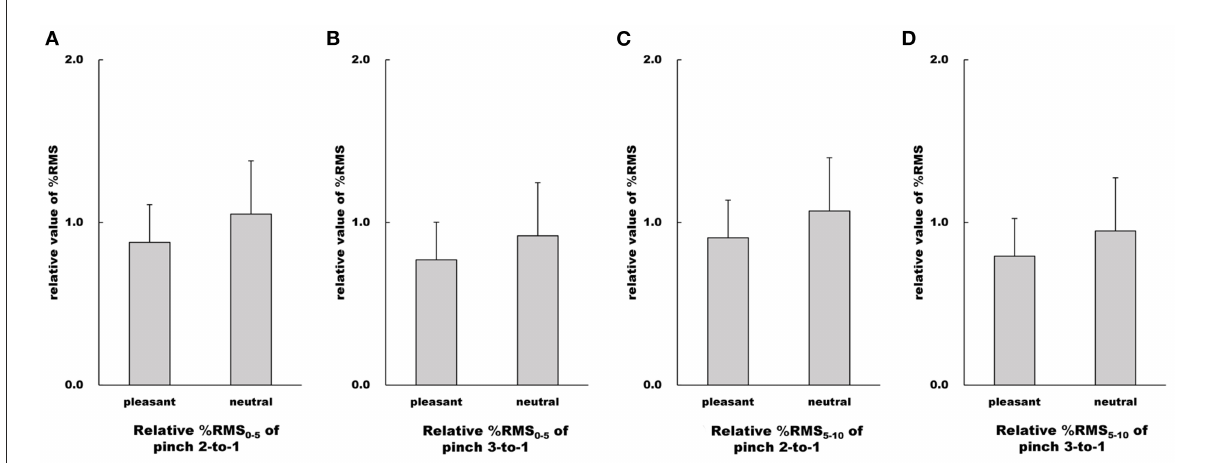
FIGURE9 Influence of emotion on relative value of %RMS. (A–D) Show relative %RMS values in the pleasant and neutral image conditions, respectfully. For parametric data, relative %RMS values are represented as mean and standard deviation. For non-parametric data, relative %RMS values are represented using the box and whisker plot, with the median shown as the middle horizontal line, the upper and lower quartiles indicated as boxes, and the maximum and minimum indicated as whiskers. The vertical axis shows relative %RMS value, and horizontal axis shows the specific image condition (pleasant and